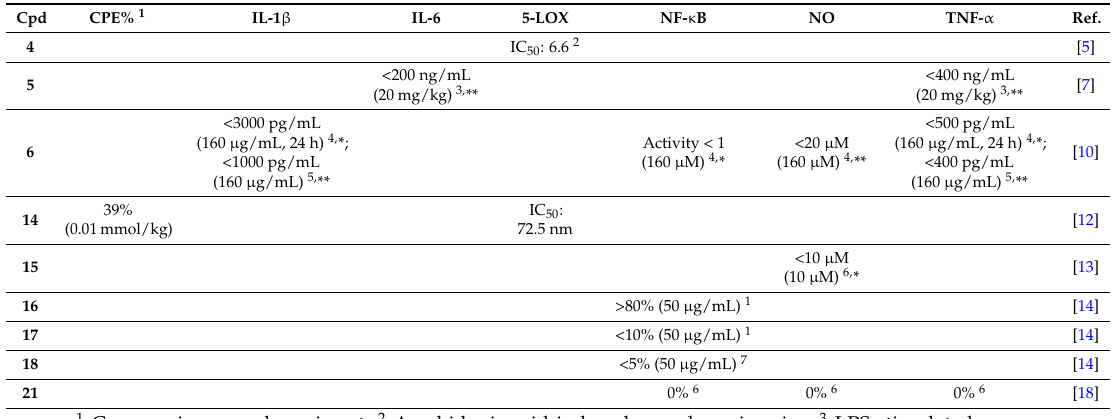
Table 1. Some anti-inflammatory activities of Simple